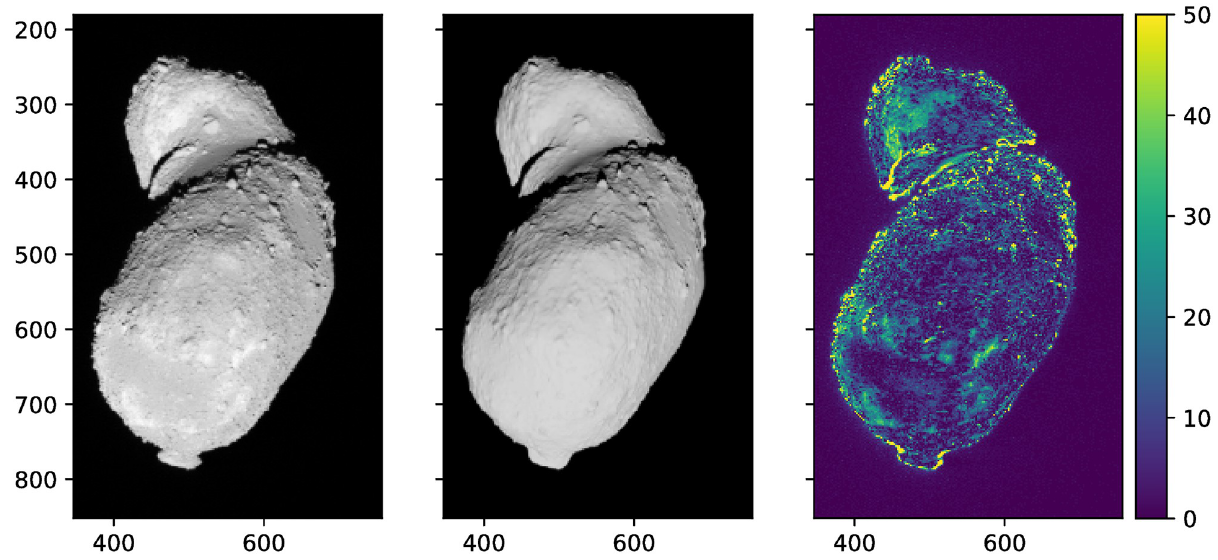
Fig 5. The pixel-by-pixel comparison of the original AMICA image on the left and generated OpenGL image in the middle. The scale indicates percent error. The AMICA image is published under Public Domain 1.0.